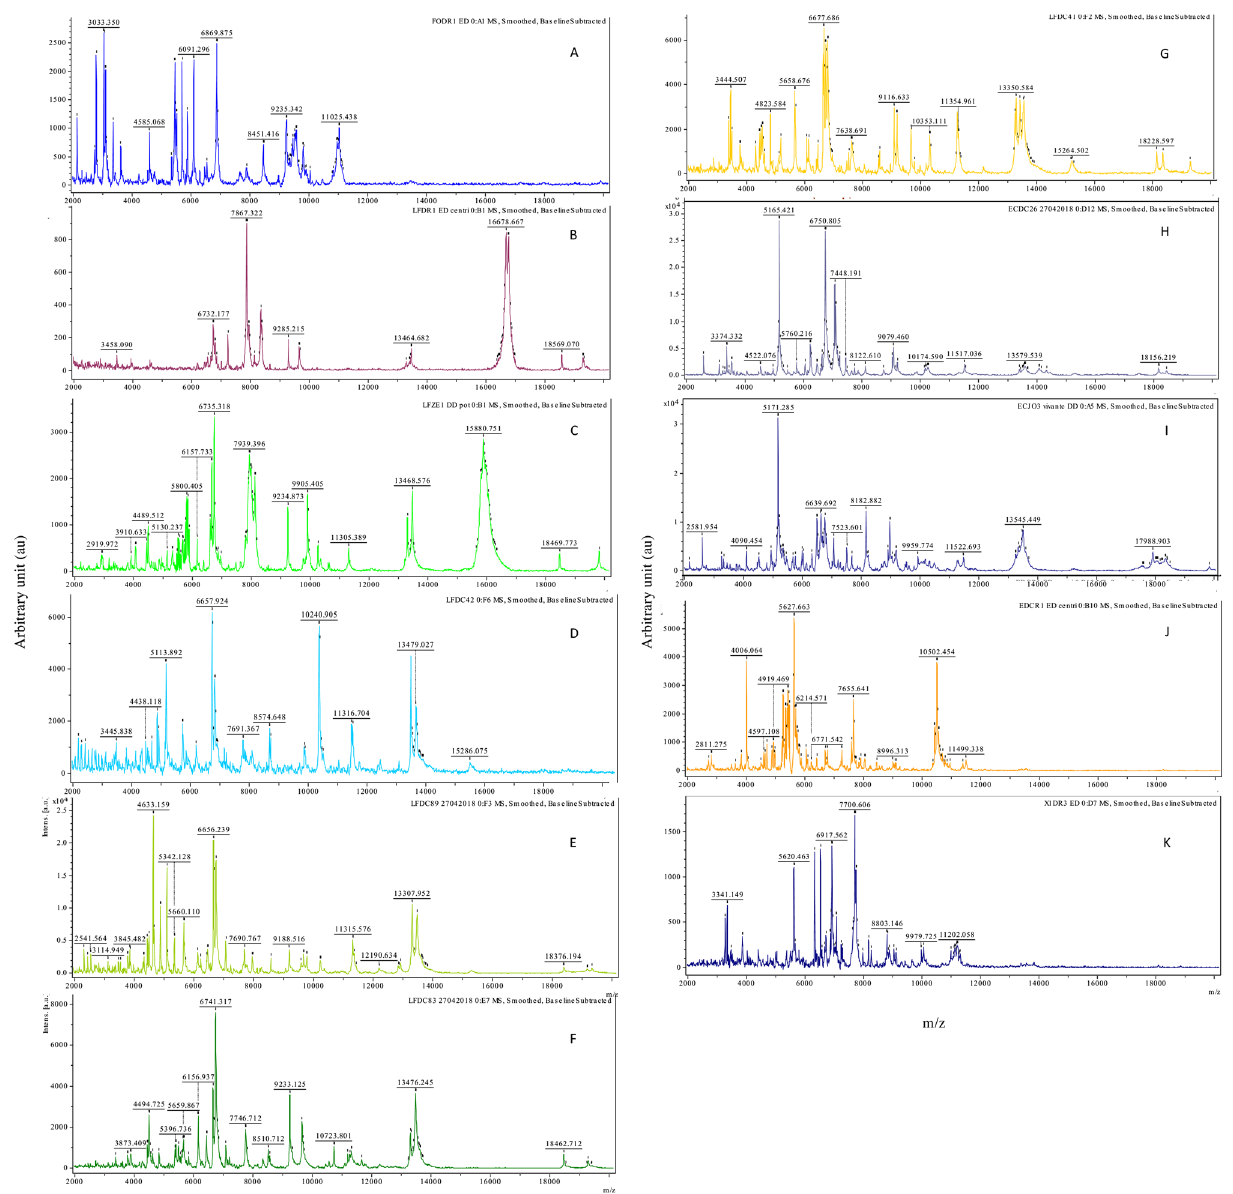
Figure 1. Representative MALDI-TOF spectra of cercariae obtained using a simple direct-deposit protocol. Flex Analysis software, smoothed spectra with baseline substracted A: Trichobilharzia anseri (FODR1) B: Diplostomum pseudospathaceum (LFDR1) C: Tylodelphys sp. (LFZE1) D: Australapatemon sp. (LFDC42) E: Cotylurus sp. (LFDC89) F: Posthodiplostomum sp . (LFDC83) G: Alaria alata (LFDC 41) H: Echinoparyphium sp. (ECDC26) I: Echinostoma revolutum (ECJO3) J: Petasiger phalacrocoracis (ECDR1) K: Plagiorchis sp.